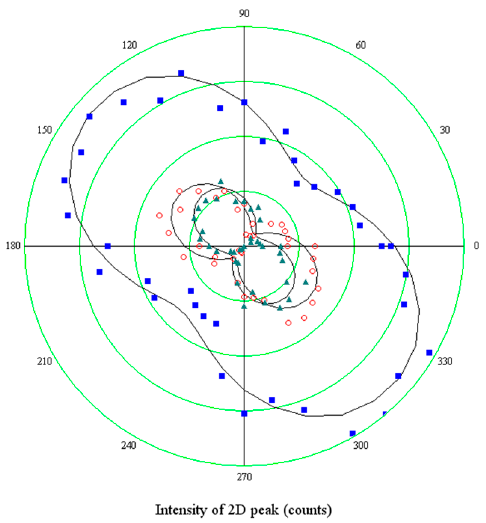
Figure 7. The same angular dependence of components of the split 2D peak shown in Figure 6b, but with the hole minor axis rotated perpendicular to the polarization axis of the laser beam.